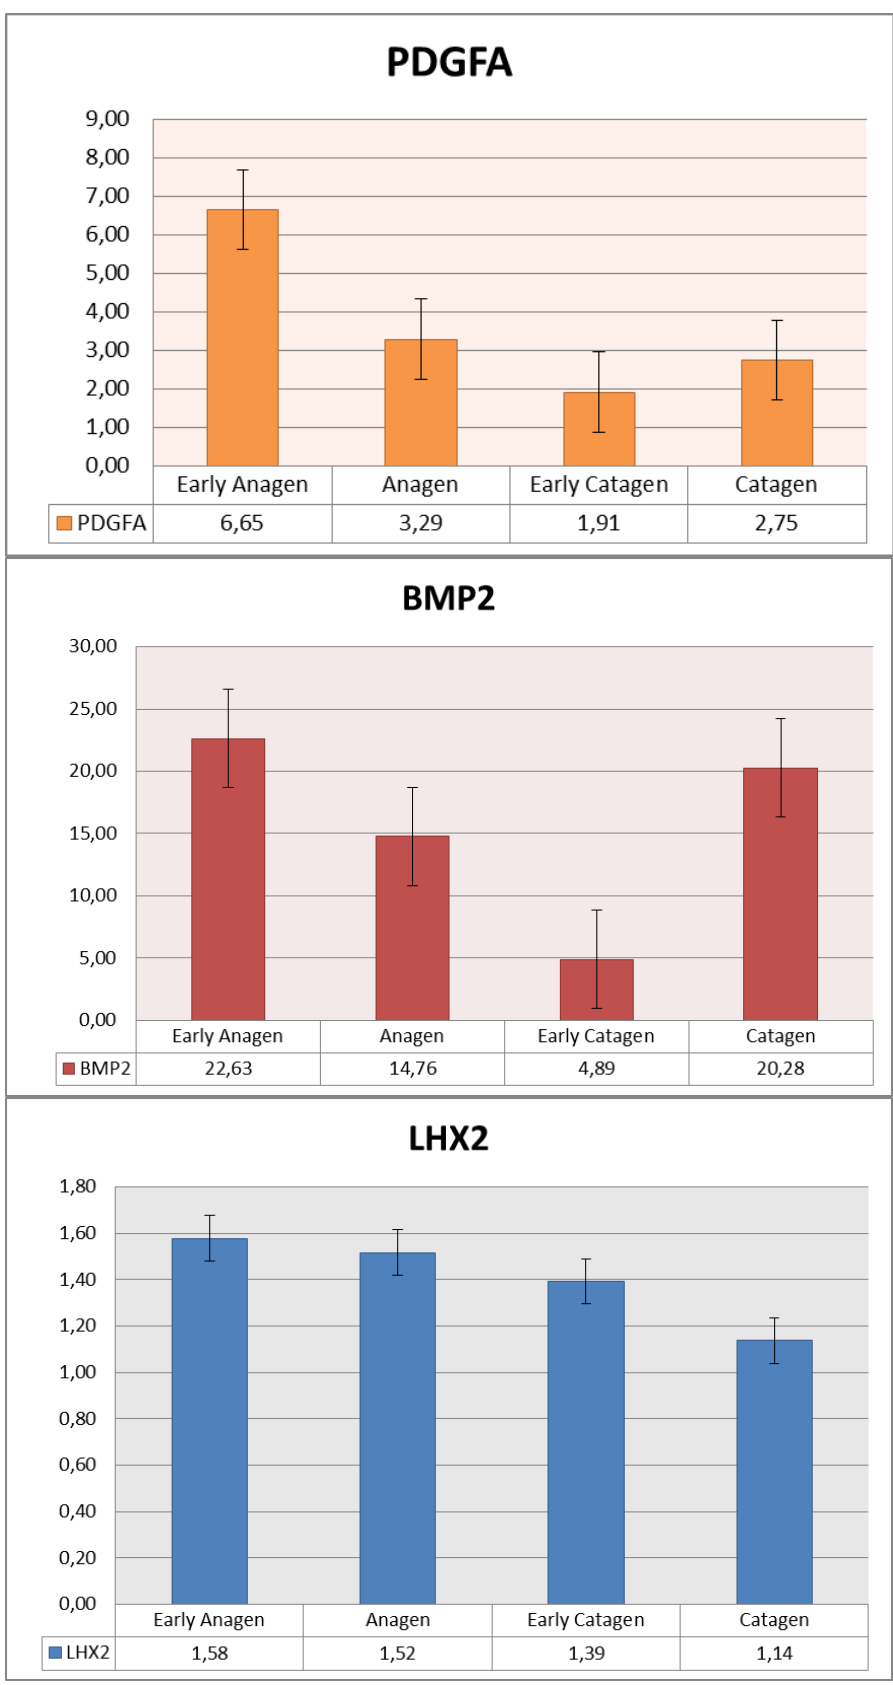
Figure 6. Expression levels of PDGFA, BMP2 and LHX2 during different phases of hair follicle (HF)